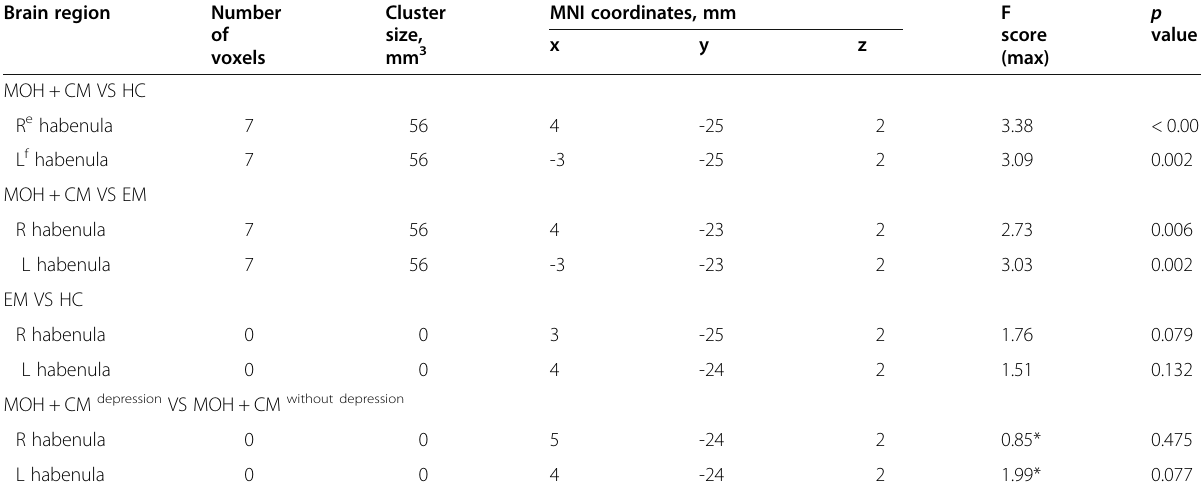
Table 2 Altered resting-state functional connectivity of the habenula and the SN a amongst MOH + CM b , EM c and HC d , and between MOH + CM subgroups with or without depression Brain region